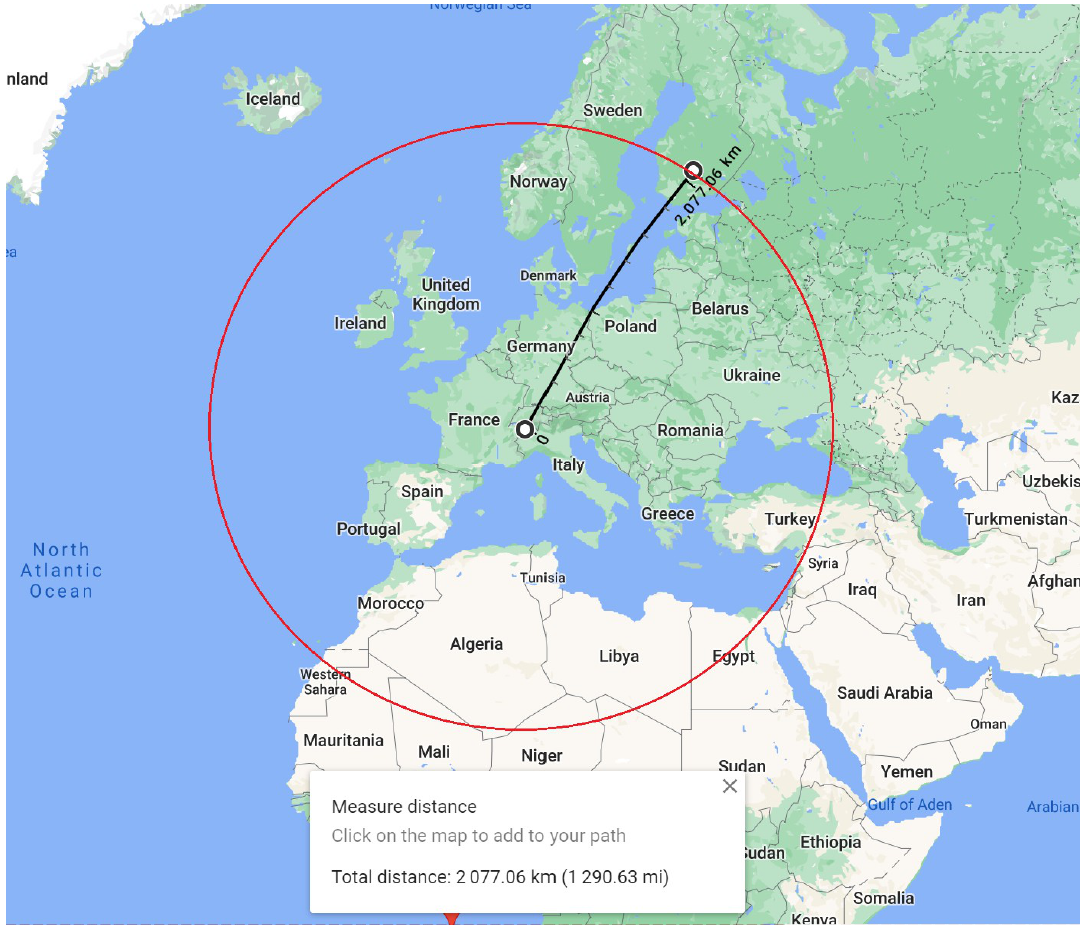
Figure 13. The idealized range pattern of the Klein Matterhorn LW radio experiment.